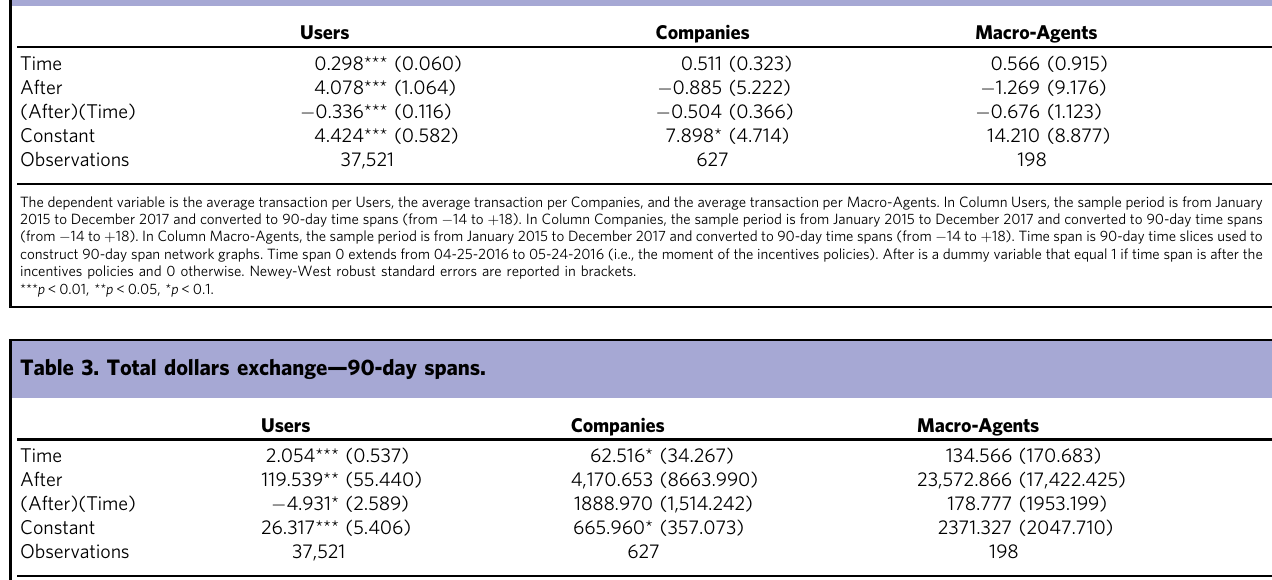
Table 2. Average transaction per node — 90-day